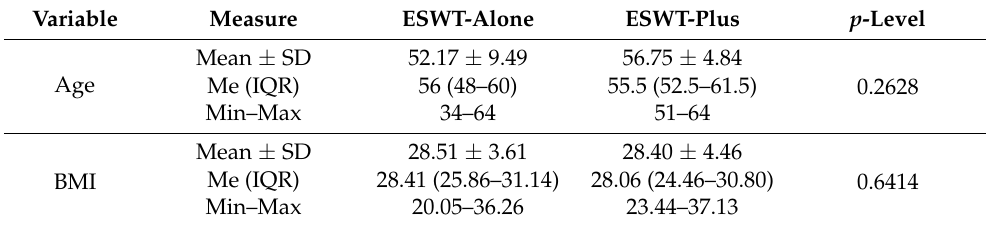
Table 2. Characteristics of patients from the two treatment groups by age and BMI.